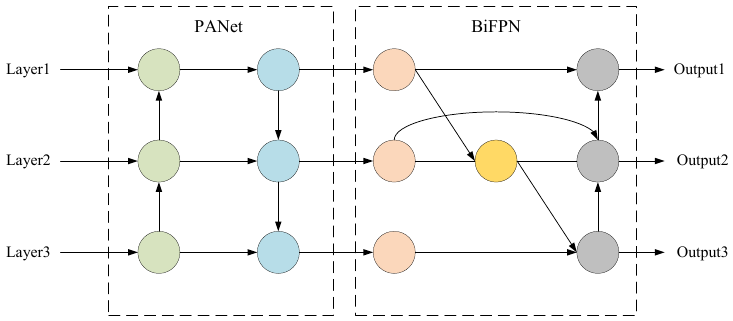
Figure 4. The structure of PB module.